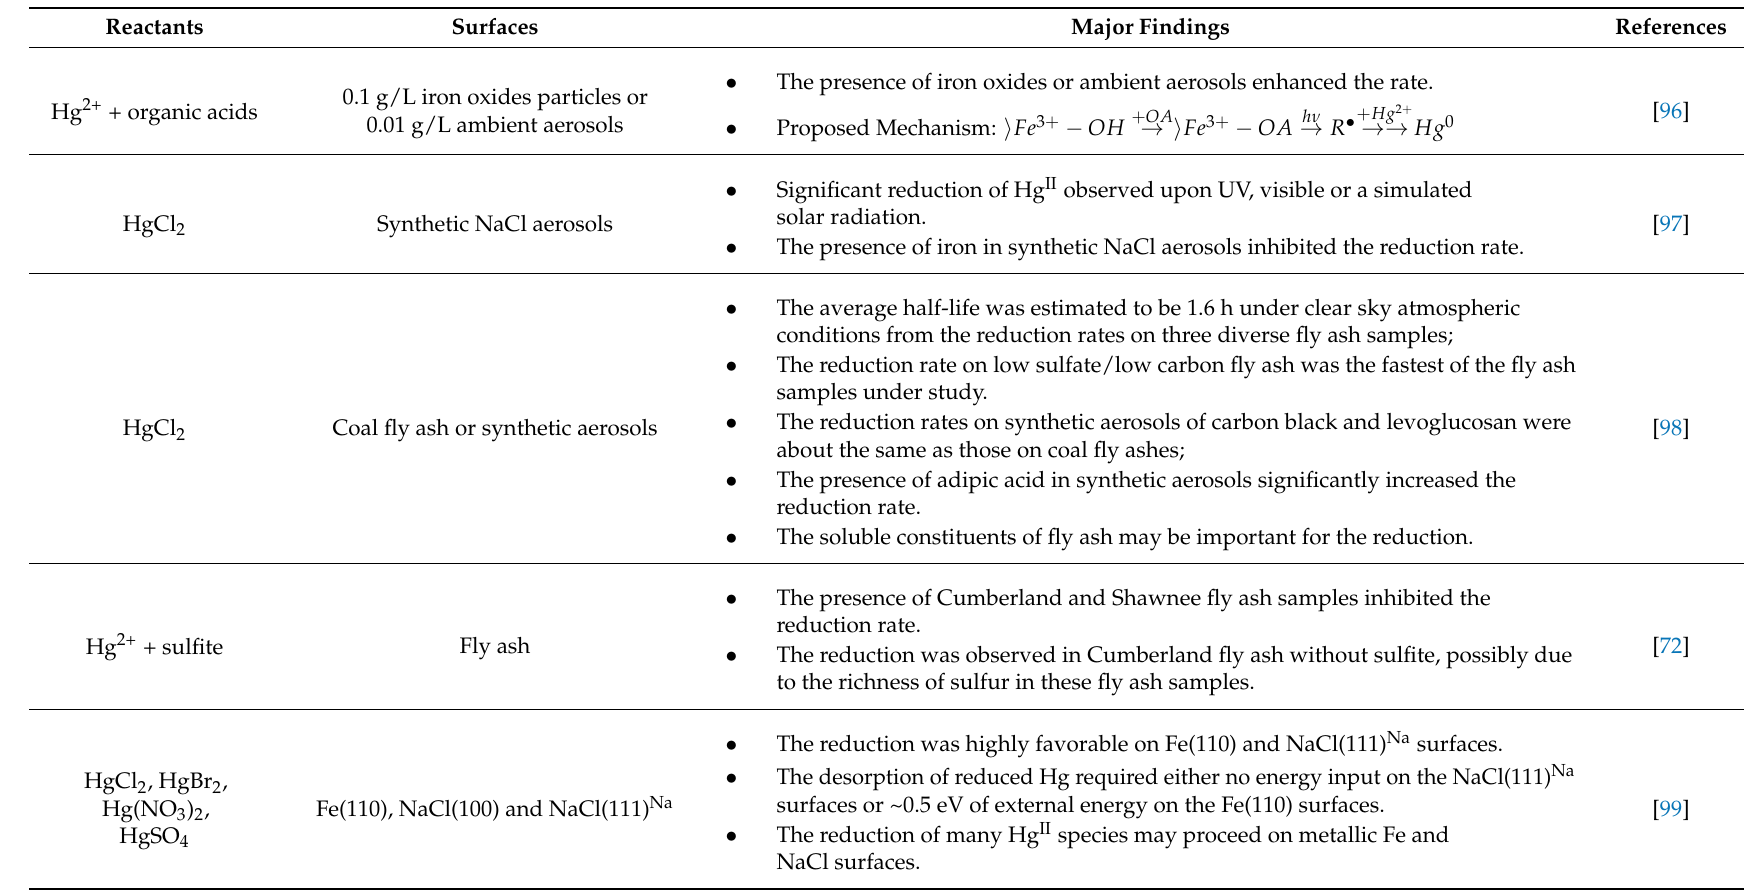
Table 3. Current accumulated knowledge on heterogeneous chemical reactions of Hg in the